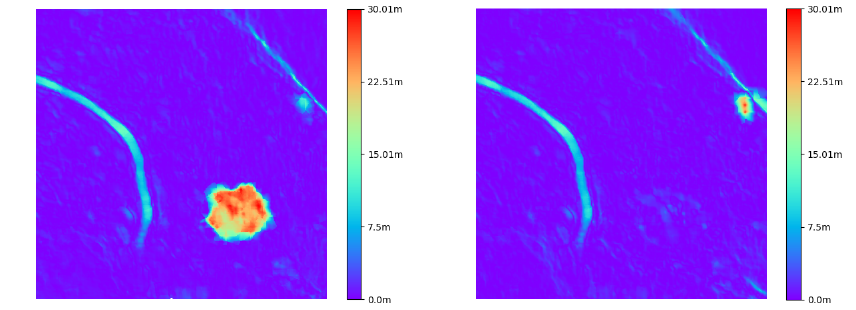
Figure 13. Differences within the original method used for ODM ( left ), and our proposed method ( right ) to estimate the ground.